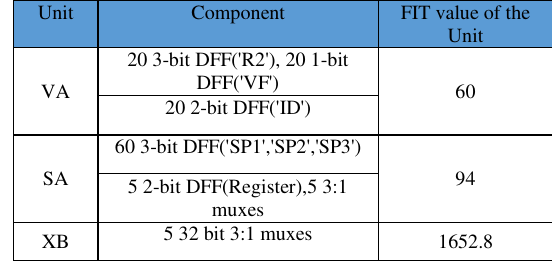
Table 1: Fit Estimation of Baseline NoC Router Unit Table 2: FIT Estimation of the Reliable Router: Protector